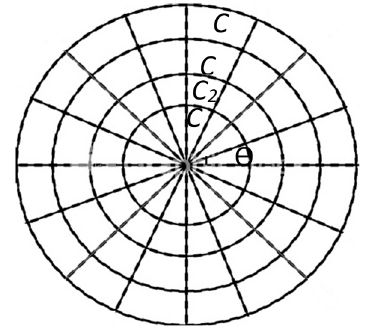
Figure 1. Clustered corona-based WSN (C is the corona number and θ denotes the angle of each sector).